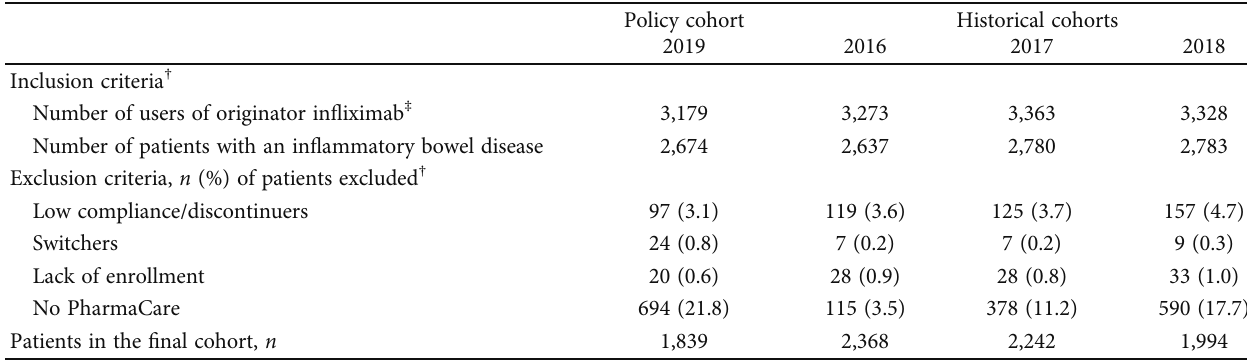
Figure 1: Use of biosimilar in fl iximab: percentage of all in fl iximab prescriptions that were for a biosimilar, by month and coverage, for adult and pediatric patients with in fl ammatory bowel diseases. The transition period of the Biosimilars Initiative started on 5 September 2019 and ended on 4 March 2020 for adults and on 15 May 2020 for pediatric patients. The black lines represent data for all prescriptions in British Columbia; the red lines represent data for prescriptions accepted by PharmaCare, the provincial drug plan. Table 1: Patient fl ow for the policy cohort and the three historical